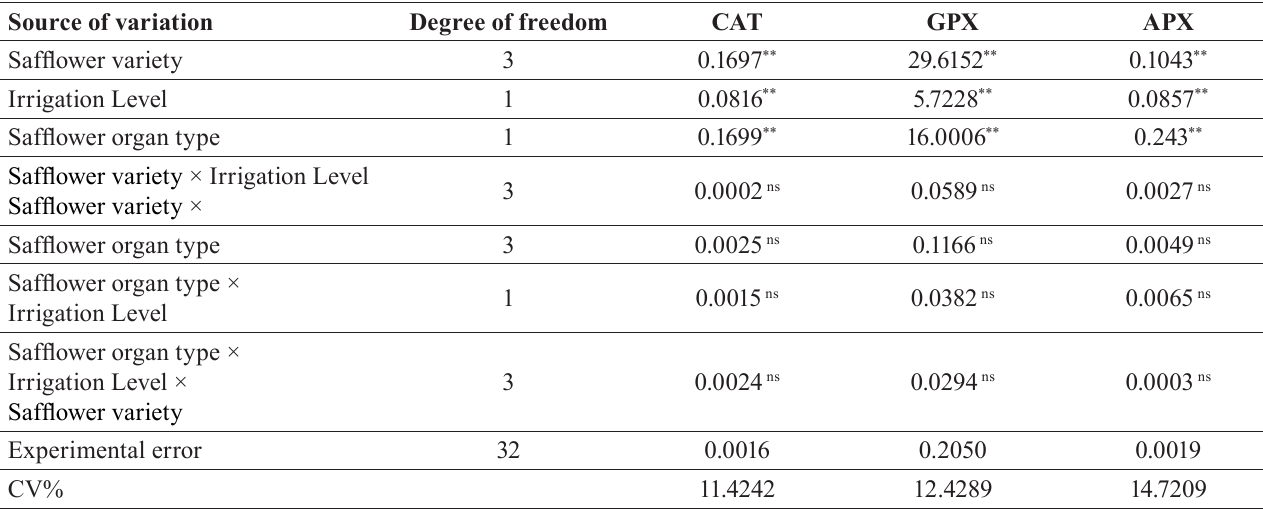
TABLE I - V ariance analysis of allelopathic effect of safflower root and shoot residue on antioxidant enzymes activities of radish seedlings APXGPXCATDegree of freedomSource of